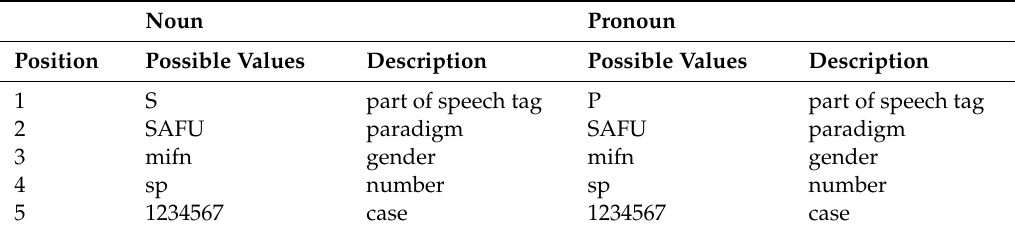
1234567 case 1234567